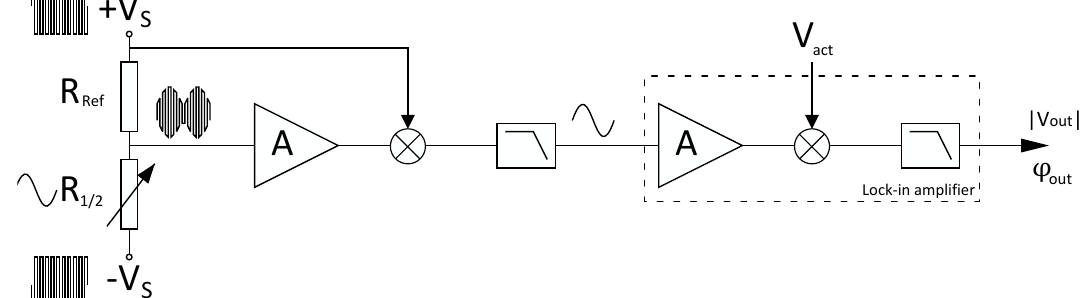
Figure 11. Schematic representation of the electronic readout circuit. The resistance of one strain gauge R 1/2 is converted to a voltage via a 1 MHz carrier signal and a reference resistor R Ref . In the case of device C (Figure 10e,f), R Ref is another strain gauge with its resistance changing in the opposite direction with respect to R 1/2 . The carrier signal is mixed out after which an SR860 lock-in amplifier determines the magnitude and phase of the signal (with actuation voltage v act as a frequency reference).